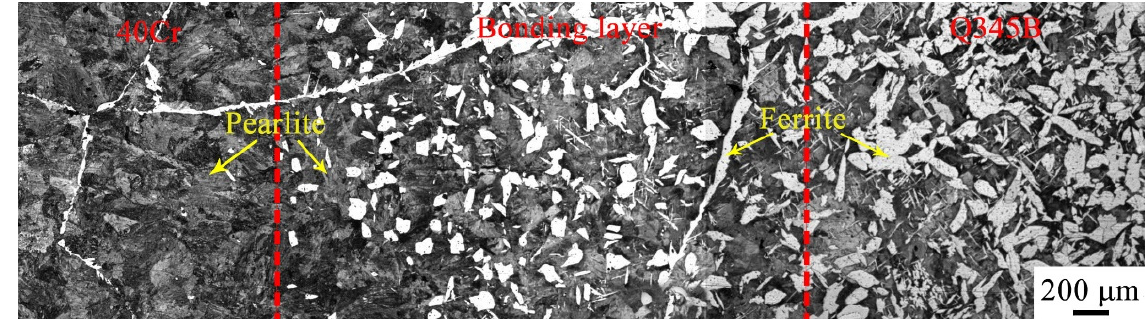
Figure 2. The initial microstructure of 40Cr/Q345B bimetallic blank.